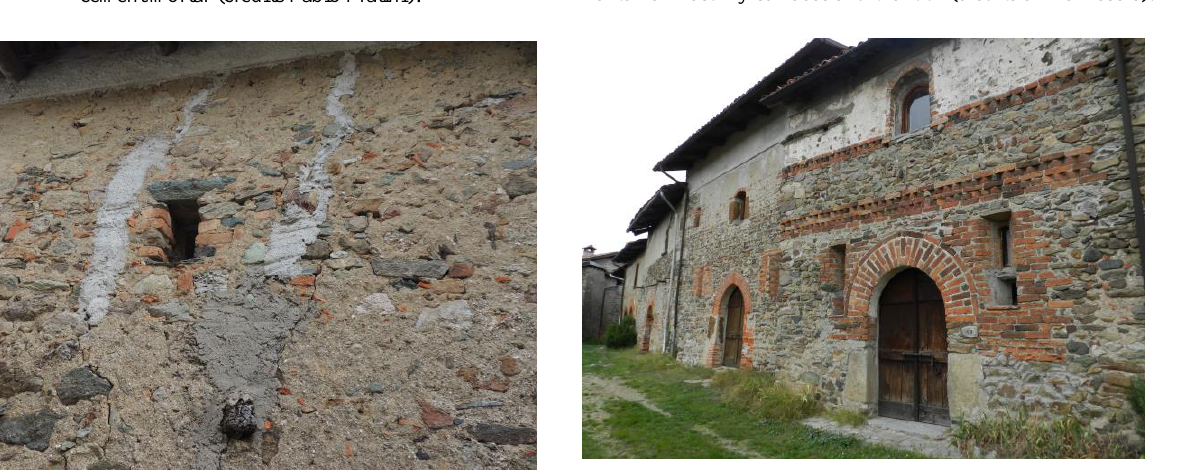
Figure 15. Building G - Filling of cracks with cement mortar (credits Fabio Fratini).